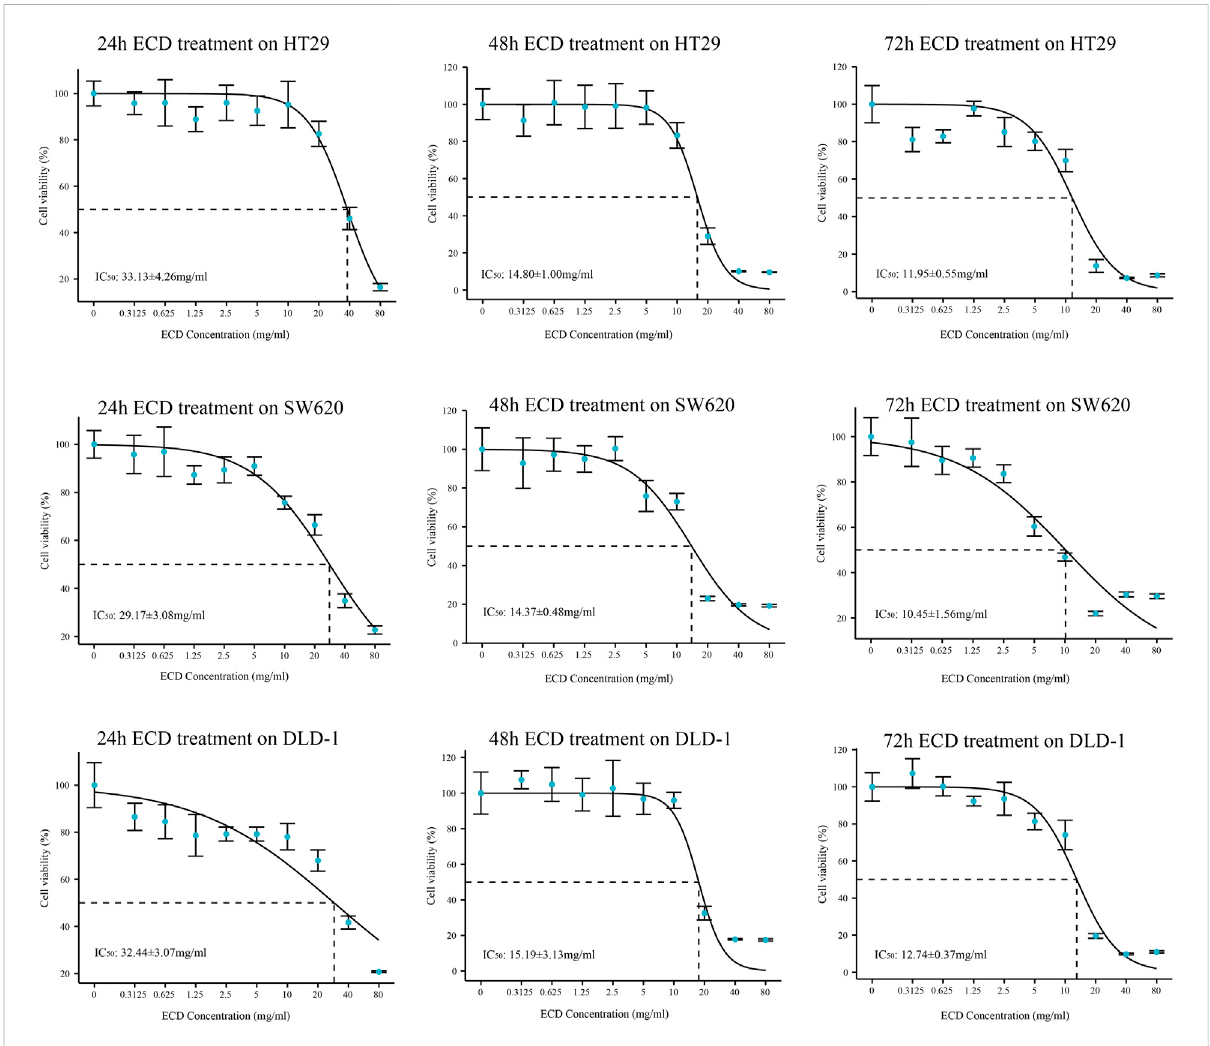
FIGURE 6 The IC 50 values of ECD in each CRC cell line (HT29, SW620, and